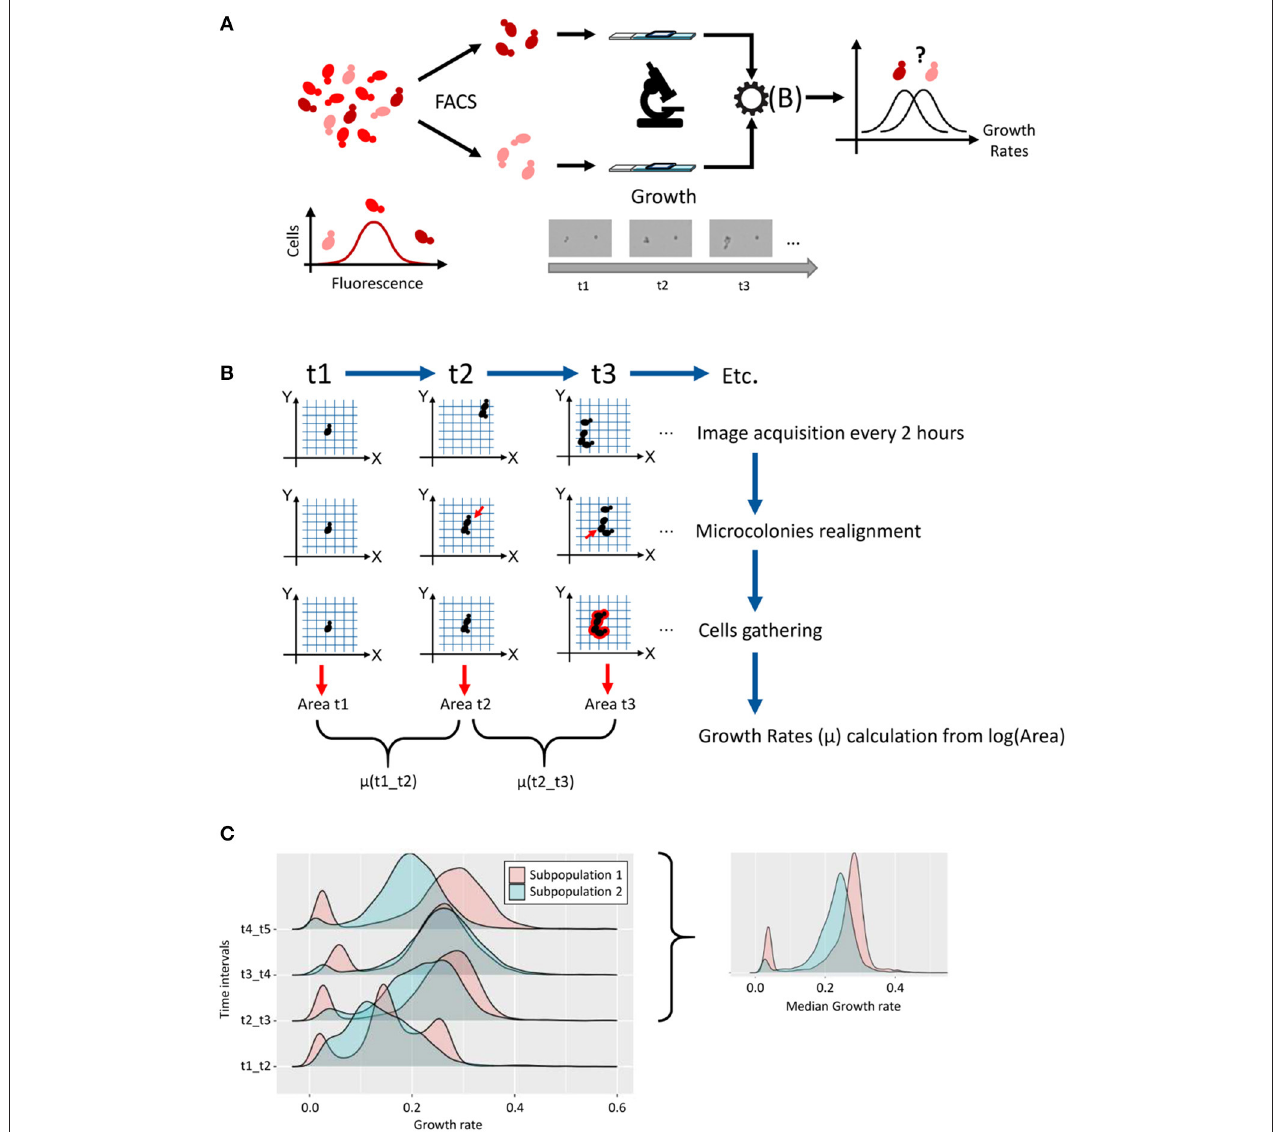
FIGURE 1 | Methodological pipeline for single-cell growth analysis. We developed a methodological pipeline to compare the growth of two subpopulations of cells that are characterized by different levels of expression of a gene of interest. This microscopic device was also used to analyze directly, i.e., without former cell sorting, the growth of strains of interest at the single cell level. (A) The first step was to sort cells based on high and low expression of a gene of interest (protein labeled with a fluorescent tag). After sorting, ∼ 5,000 cells were fixed and grown in microchambered slides filled with liquid medium. A scan of the slides was performed every 2h for 8h, to follow the growth of every single microcolony. The collected data give us access to several parameters as areas ( µ m 2 ) and XY coordinates on the slides. After data treatment [see (B) ], the distribution of the growth rate of thousand microcolonies could be plotted and samples compared. (B) Data treatment to estimate growth rates. This relied on customized Python scripts that allowed: Colonies realignment, which provided a corrective to the shift of the XY coordinates, due to the manual repositioning of the glass slides under the microscope objective at each time point; Cells gathering to correct splitting of the microcolony; Growth rate calculation between time points, from log(area) values, for each microcolony. (C) For each time interval, the distribution of growth rates of thousands microcolonies was presented as density plots. By excluding the first 2h (initial lag phase, t1–t2 interval) and taking the median value of the three growth rates calculated for the following time intervals, for each microcolony, we obtained a smoothed distribution of growth rate in the